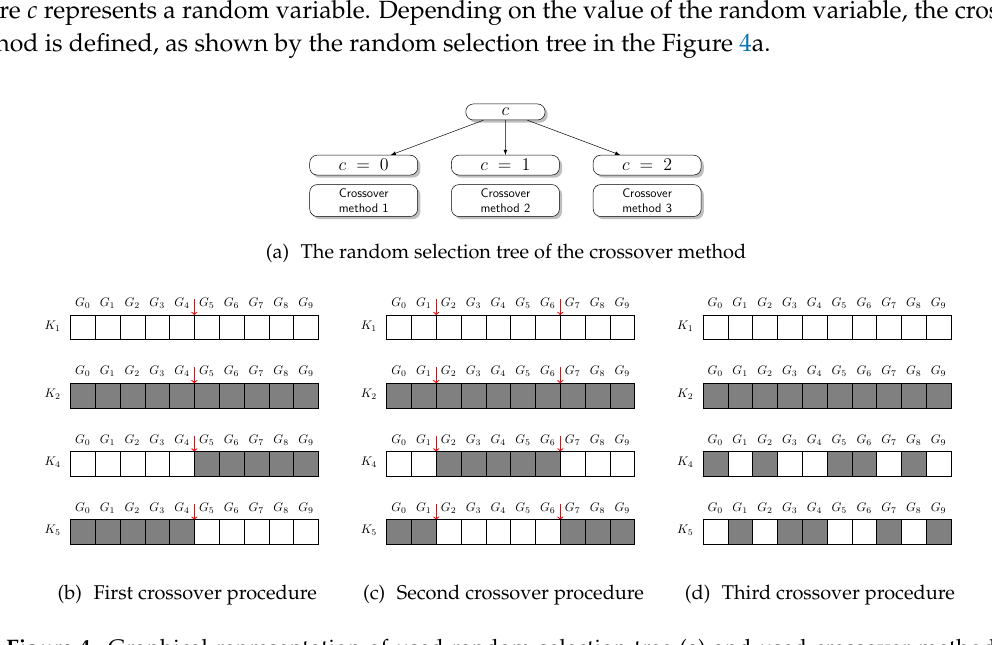
Figure 4. Graphical representation of used random selection tree ( a ) and used crossover methods ( b – d ) ( K 1 - first parent chromosome, K 2 - second parent chromosome, K 4 - first child chromosome, K 5 - second child chromosome, G -